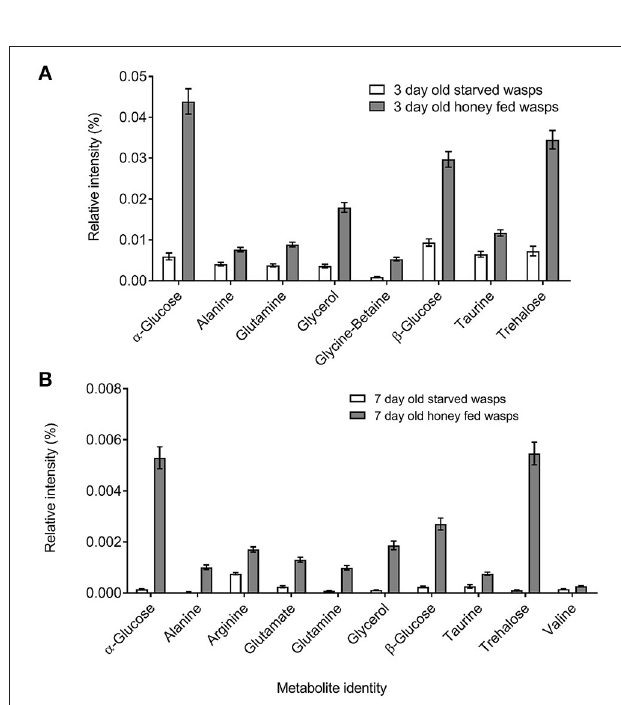
FIGURE 2 | Polar metabolite differences between starved and honey-fed G. legneri (A) metabolite differences between 3-day old starved and 3-day old honey-fed G. legneri (B) metabolite differences between 7-day old starved and 7-day old honey-fed G. legneri . The displayed values consist of the mean normalised metabolite area, error bars show 1 standard